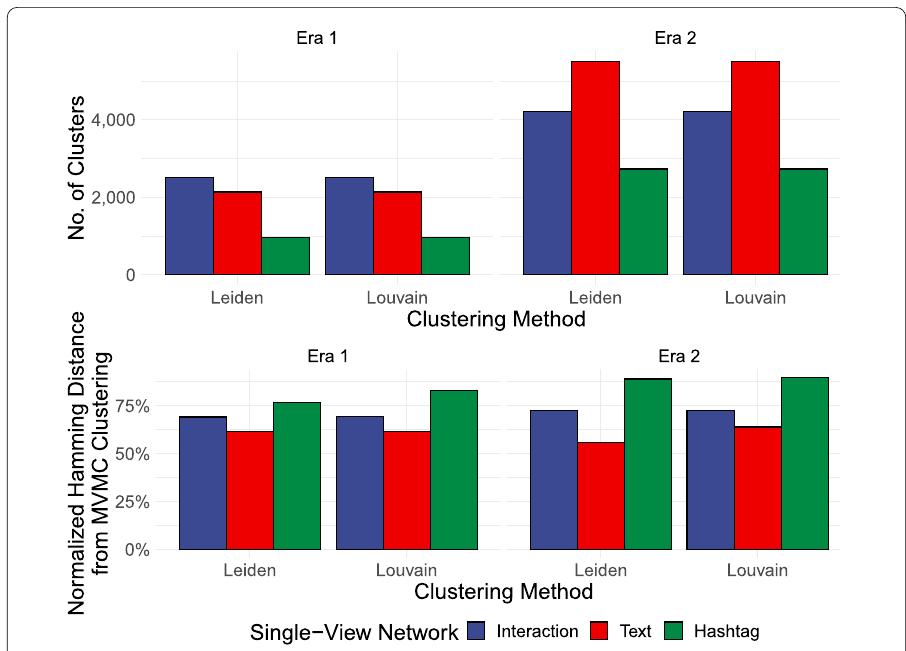
Figure 5 Comparison of MVMC clustering results with unimodal Louvain and Leiden baselines. Top: Baselines produce a significant number of degenerate clusters. Bottom: Baselines also capture only a fraction of coordinated